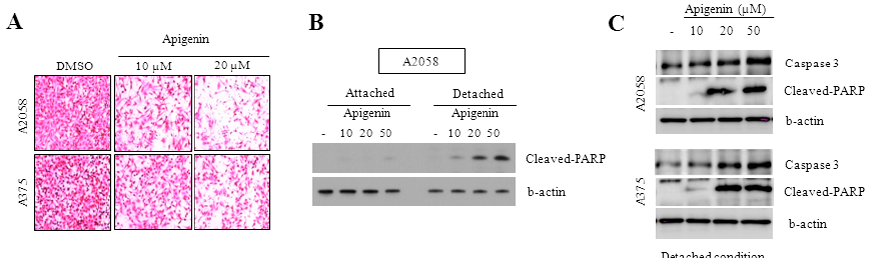
Figure 4. Effect of apigenin on the inhibition of cell migration. ( A ) A375 and A2058 melanoma cells migration was performed using Transwell chambers. Cells were incubated with various concentrations of apigenin for 6 h. Cell morphology was examined under a light microscope; ( B , C ) Caspase-3 and cleaved-PARP expressions were measured in attached and detached condition by western blotting analyses. All data are representative of three separate